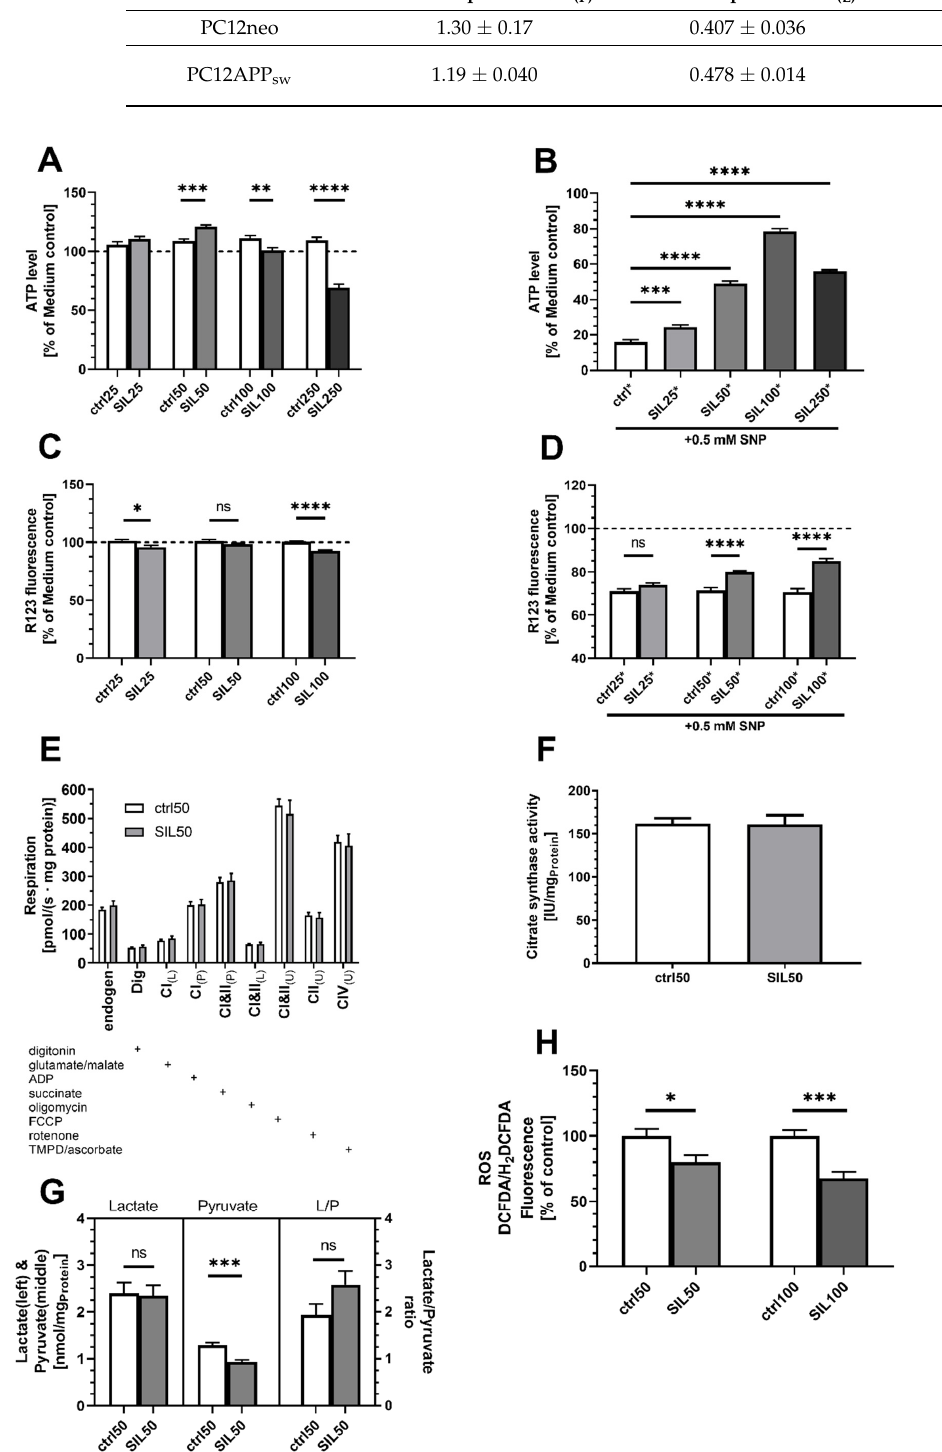
Figure 2. Mitochondrial function in PC12APP sw cells treated with SIL in various concentrations. ( A ) ATP Level (% of medium control). Cells were incubated with SIL (SIL) in different concentrations (25–250 µM) for 24 h and measured against control cells treated with DMSO. DMSO treated cells showed no significant difference compared to the medium control. ( B ) ATP level (% of medium control) of cells injured via the addition of 0.5 mM SNP 1 h after the initial incubation with